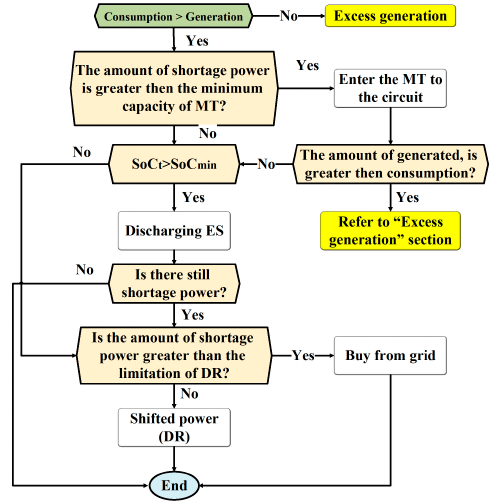
Figure 4. The algorithm of shortage power section .